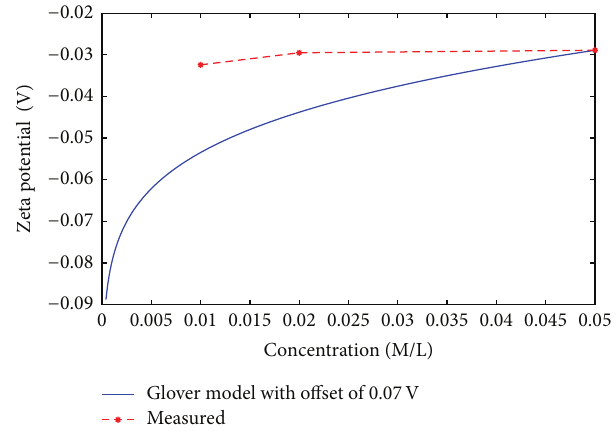
Figure 4: Zeta potential versus electrolyte concentration for sample